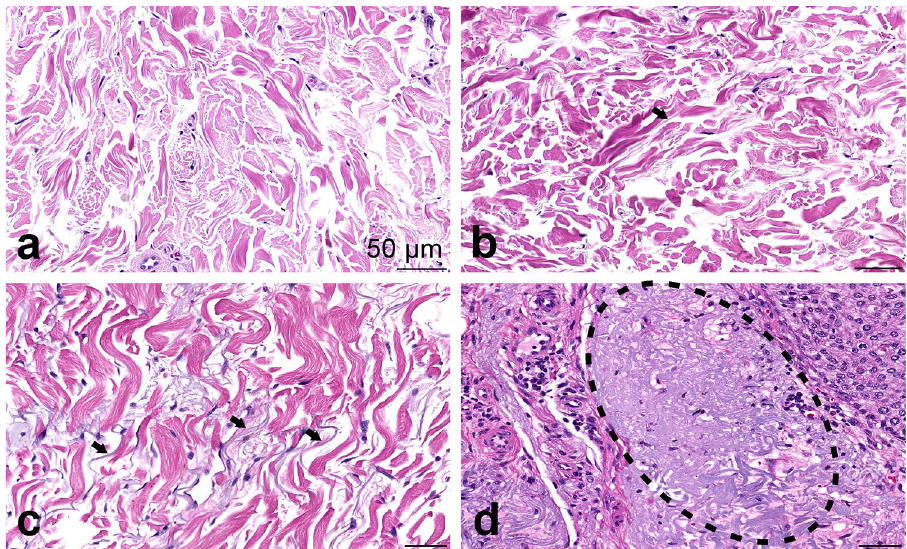
Figure 3. Examples of solar elastosis grading. ( a ) No visible fibres, grade 0. ( b) Arrow points to a single elastic fibre. Grade 1. ( c ) Arrows point to bunches of fibres. Grade 2. ( d ) Dotted line circles the homogeneous basophilic material. Grade